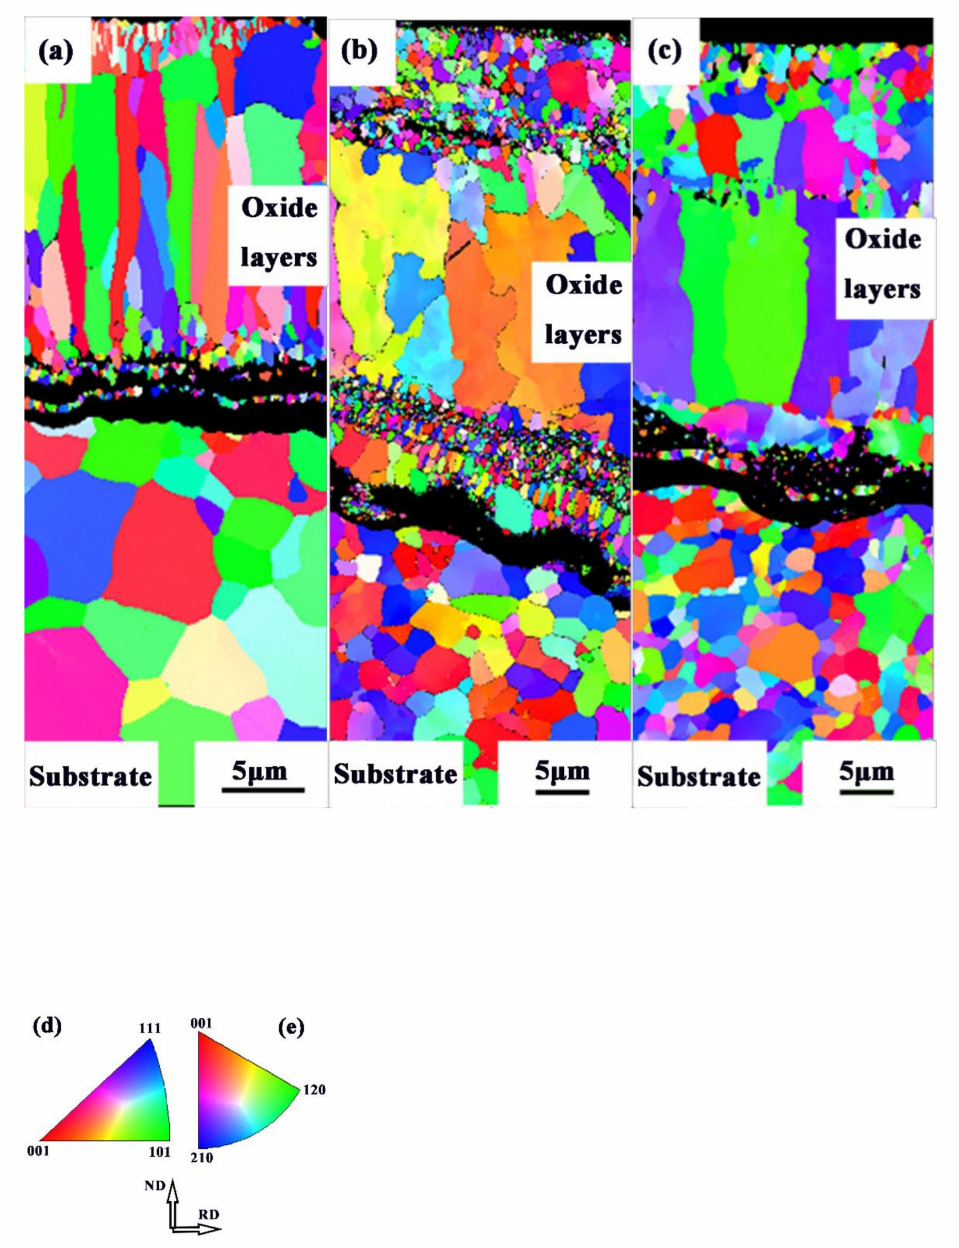
Figure 6. Electron backscatter diffraction grain orientation distribution map with the reduction rate and cooling rates of ( a ) 10%, 11 ◦ C/s, ( b ) 15%, 18 ◦ C/s, and ( c ) 27%, 27 ◦ C/s, a color distinction for the ( d ) cubic crystal system, FeO, and Fe 3 O 4 , ( e ) Fe 2 O 3